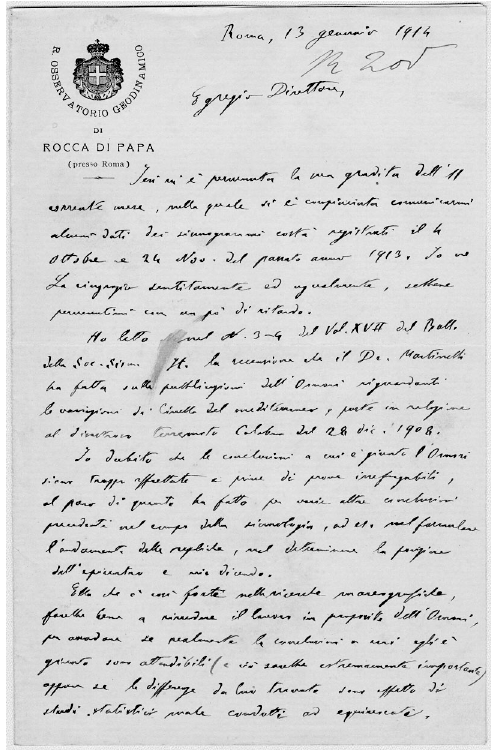
Fig. 4. First sheet of the letter from G. Agamennone to G. Grablovitz of 13th January 1914 with the invi- tation to examine more thoroughly the use that F. Omori had made of the mareographic data of Ischia for his study at on the sea-level variation connected with the earthquake of the Straits of Messina on 28th December 1908 (Grablovitz